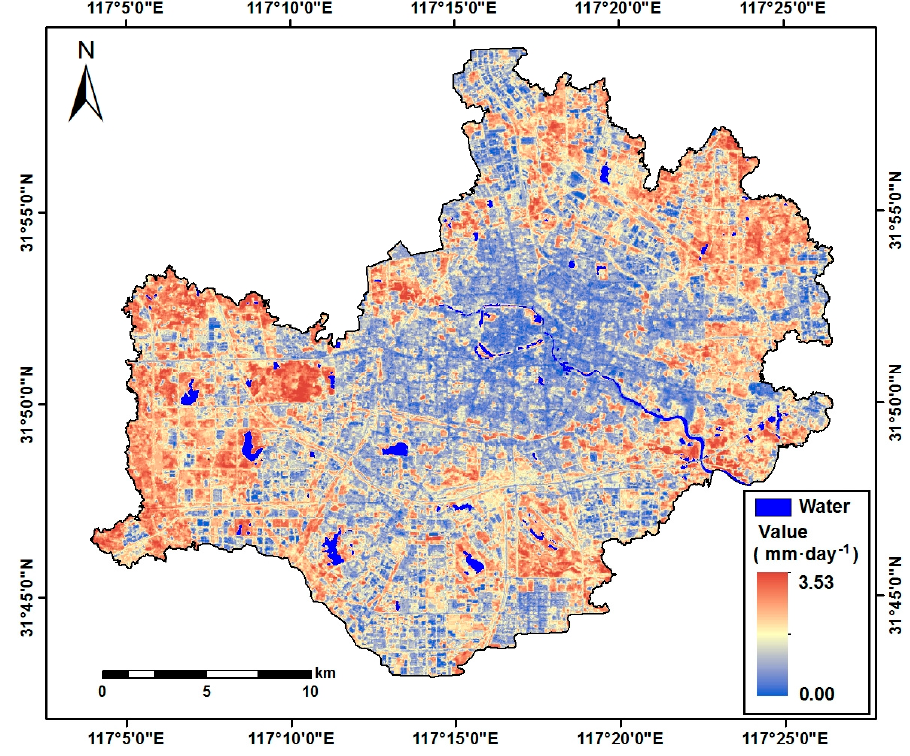
Figure 12. The spatial variability of daily evapotranspiration of Hefei’s urban built-up area on 13 October 2013, inferred from our modified model.